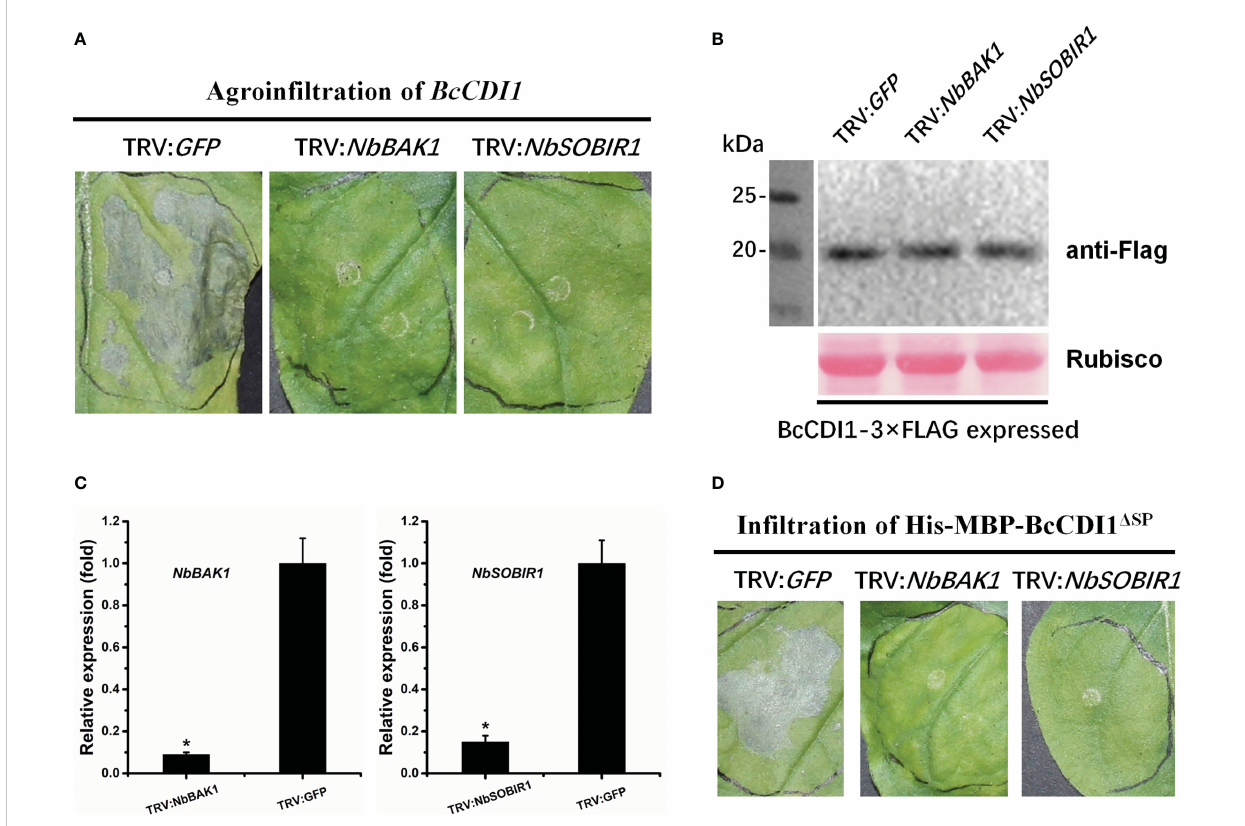
FIGURE 7 The necrosis-inducing activity of BcCDI1 is mediated by NbBAK1 and NbSOBIR1 . (A) Three weeks after the initiation of VIGS, BcCDI1-3×Flag was transiently expressed in the gene-silenced leaves using agroin fi ltration. The leaves were photographed 5 days after treatment. (B) Immunoblot analysis of proteins from the indicated Nicotiana benthamiana leaves with transient expression of BcCDI1-3×Flag . Top panel: BcCDI1-3×Flag was detected using the anti-Flag antibody; bottom panel, staining of the Rubisco large subunit with Ponceau S. (C) NbBAK1 and NbSOBIR1 expression levels in gene-silenced tobacco leaves were determined by RT-qPCR analysis. The expression level in the control plants (TRV: GFP ) was set as 1. NbEF1 a was used as an endogenous control. Data represent means and standard deviations from three biological replicates. Asterisks